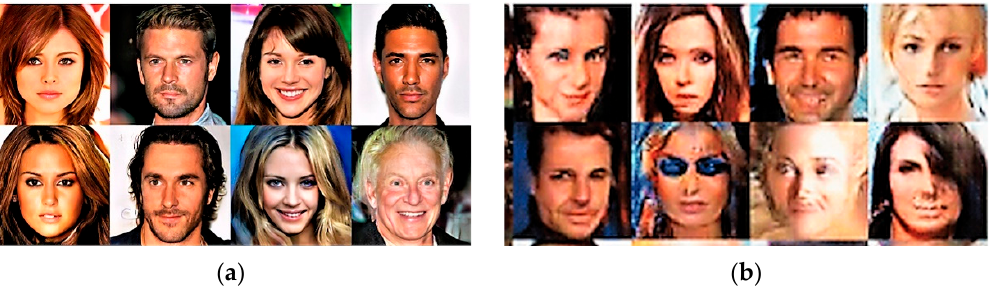
Figure 26. The results generated on the ‘Celeb A dataset’ using: ( a ) the progressive growth GAN; and ( b ) WGANs with gradient penalty.